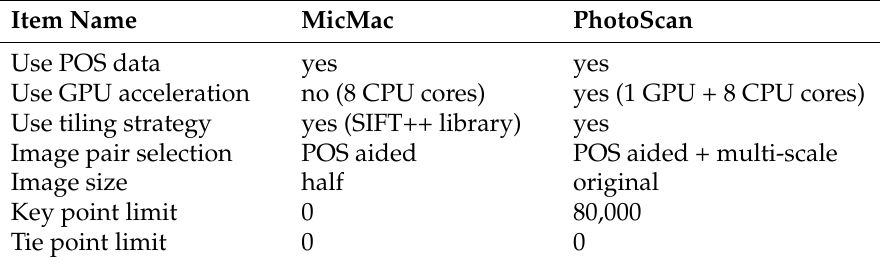
Table 6. Software configuration for comparison